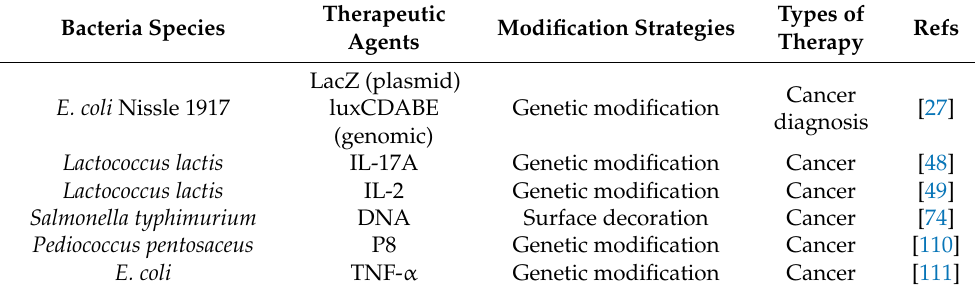
Figure 7. Bioengineered EcN for inflammatory bowel disease (IBD) treatment. ( A ) Self-assembly of modified curli into fibrous matrices. ( B ) Structure of curli fiber protein CsgA (yellow) fused with the trefoil factor domain (green). ( C ) Oral delivery of engineered probiotics to the site of inflammation in the GI tract. ( D ) Schematic illustration of the protective mechanisms of engineered probiotics in IBDs. Adapted with permission from [58]; published by Frontiers Media S.A, 2017. Table 2. Therapeutic biomacromolecules orally delivered for bacteria-mediated cancer